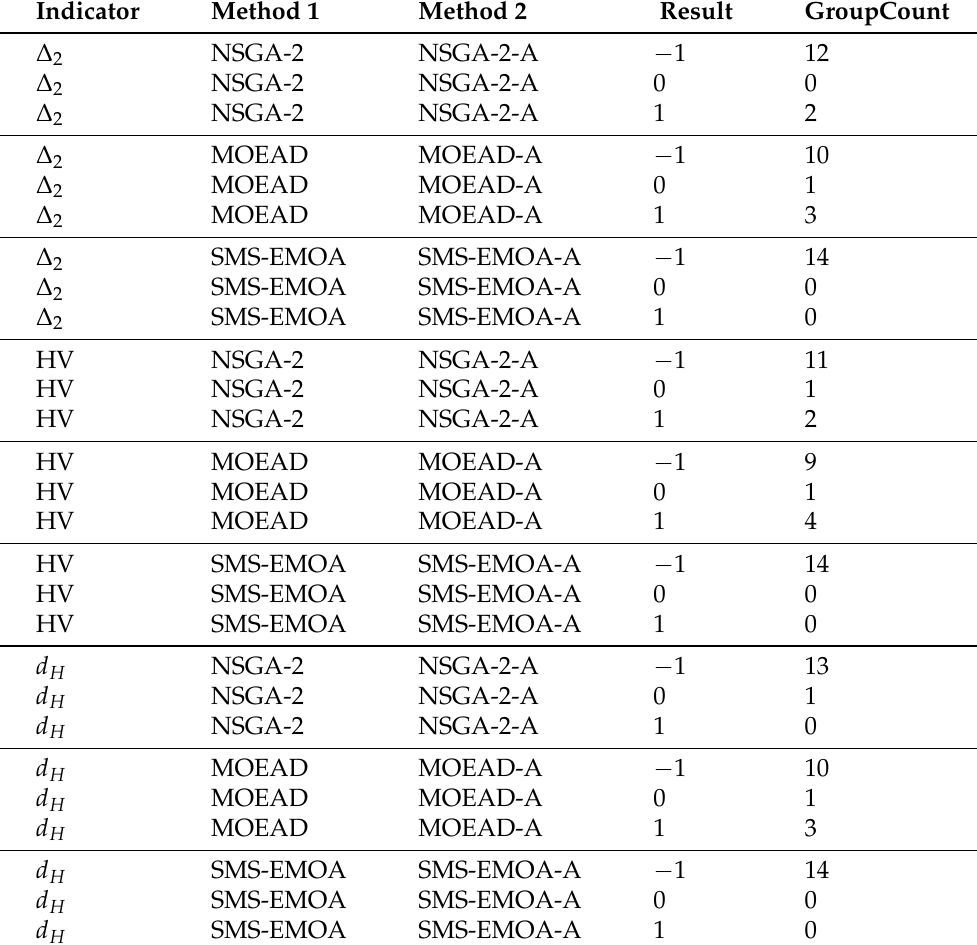
Table 2. Comparison (wins (1) / ties (0) / losses ( − 1)) of the results of the base MOEAs against their archive equipped variants on the 14 three-objective test problems. The Wilcoxon rank-sum test has been used for statistical significance, where p -value <